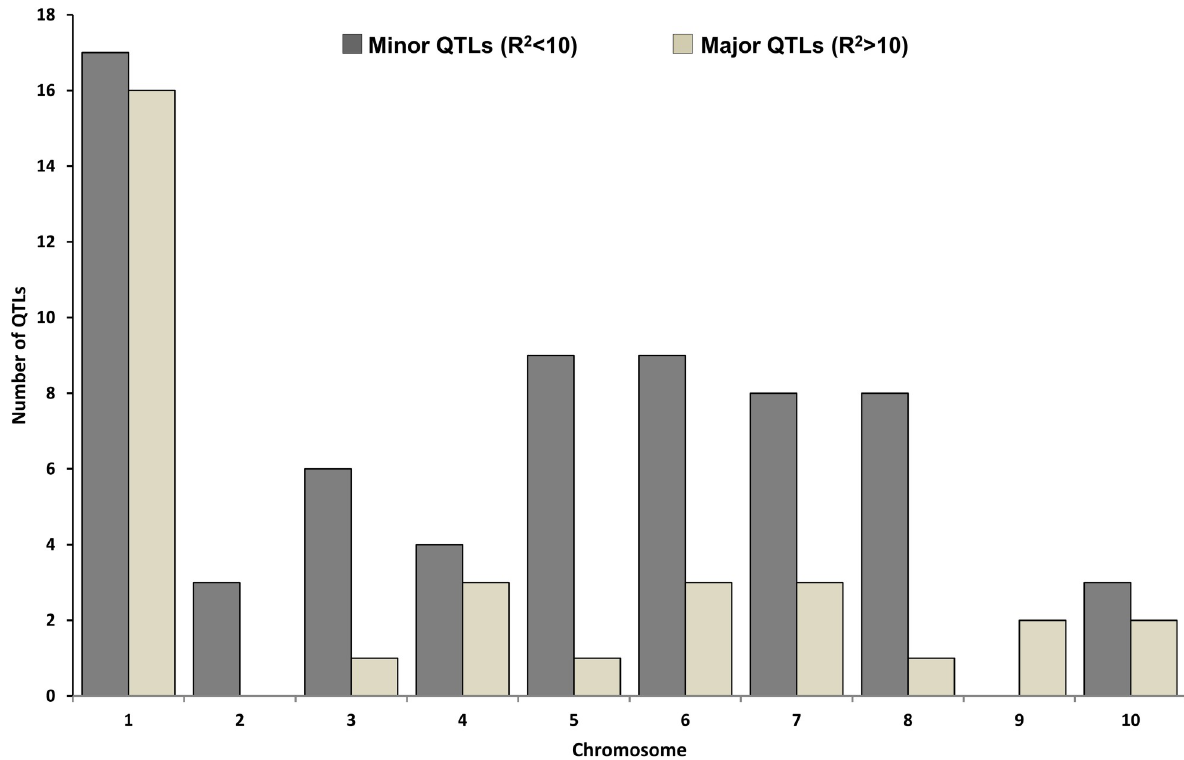
Fig 2. Details of QTLs of the experiments used in meta-QTL analysis indicating total number of major QTLs (R 2 > 10) and minor QTLs (R 2 < 10). Sixty seven out of the total 99 QTLs were minor, whereas rest of the thirty two QTLs were major. Indicating the control of large number of small effect QTLs and a few major effect QTLs and hence revealing the complex genetic architecture of popping